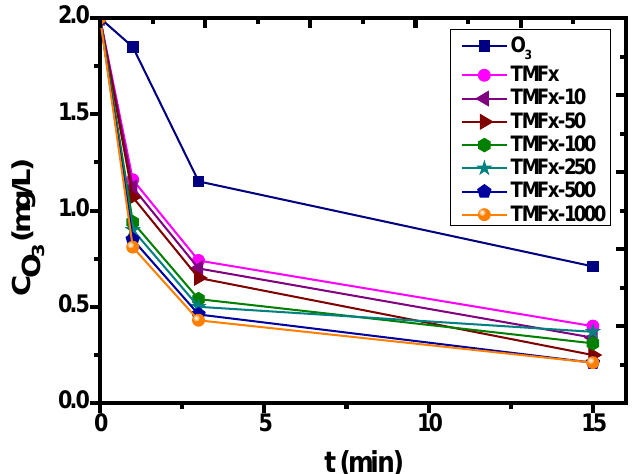
Table 4. Adsorption loading of p‐CBA ( C o = 4 μM) on different initial concentrations of PET catalyst.